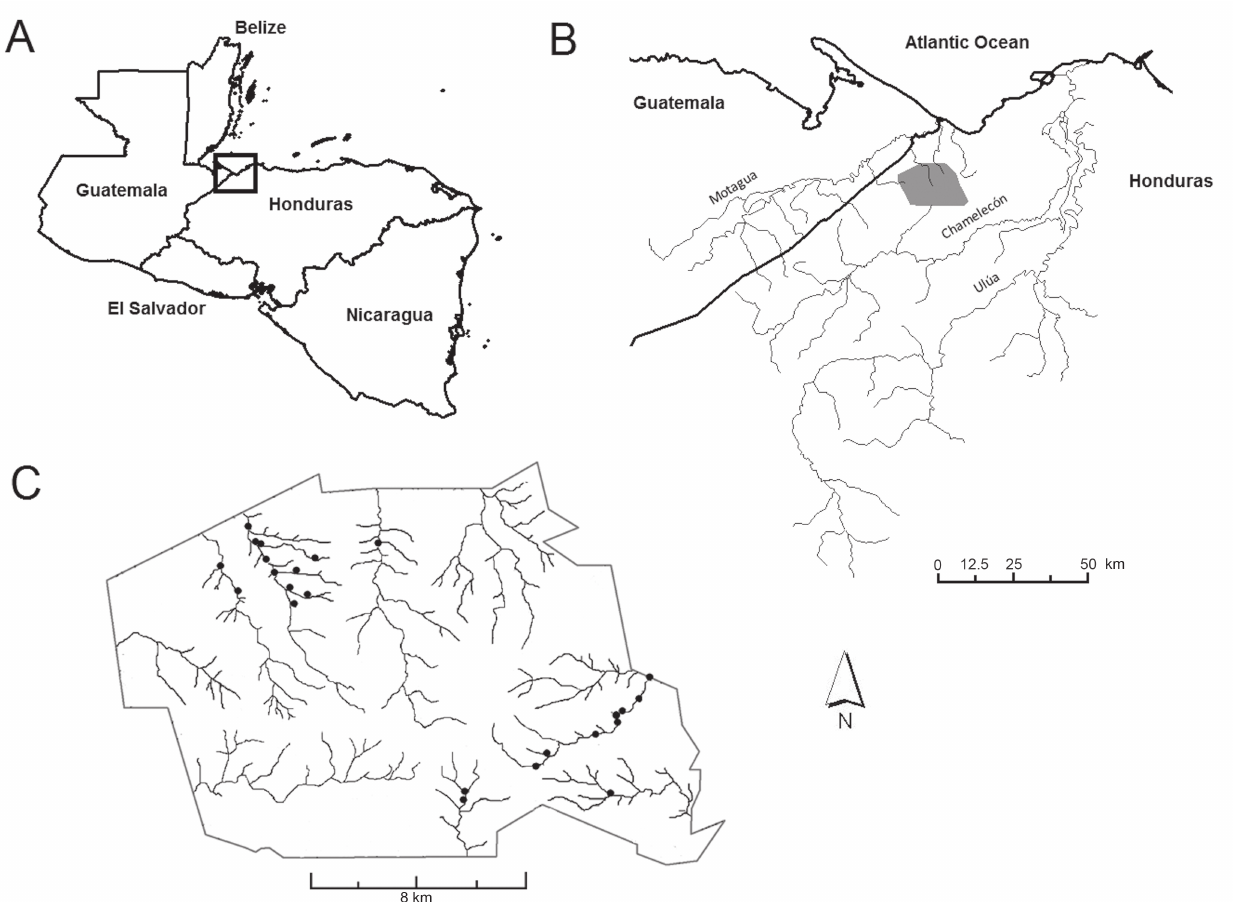
Fig. 1 . (A) Mainland Central America, with a square representing the inset of (B), Cusuco National Park (gray) within the río Motagua (Guatemala) and río Chamelecón/Ulúa (Honduras) basins. (C) Sites (black dots) sampled from upstream to downstream on 6 tributaries to the río Motagua (west side) and río Ulua (east side) in Cusuco National Park, Honduras, Central